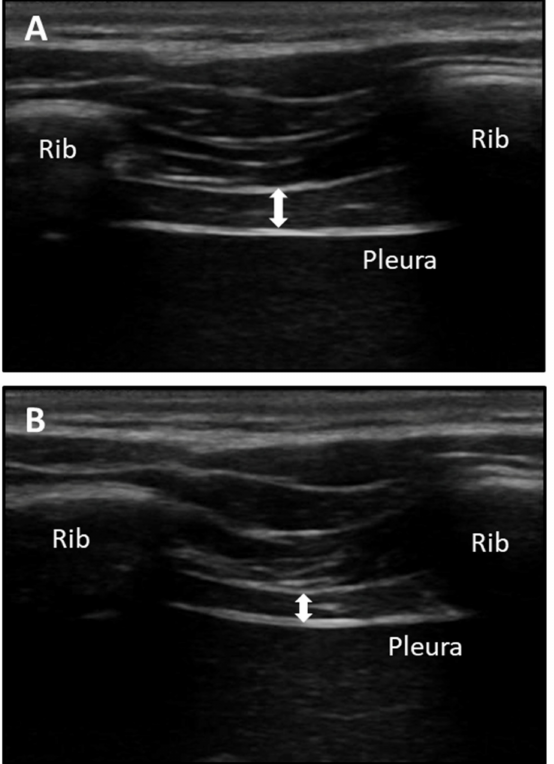
Figure 2. B-mode diaphragm thickness ultrasound imaging visualizing the last intercostal space following the mid-axillary line from the inferior edge of the 11th rib to the superior edge of the de la 12th rib of the thorax. ( A ) Diaphragm thickness (white arrow) at maximum inspiration (T ins ) during relaxed breathing. ( B ) Diaphragm thickness (white arrow) at maximum expiration (T exp ) during relaxed